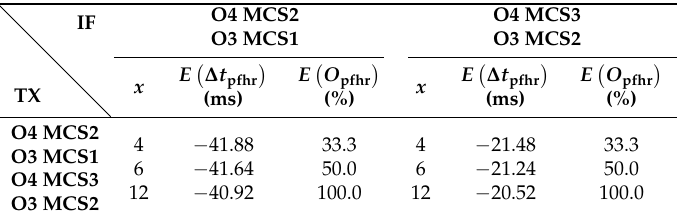
Table 5. Timing offsets and PHY frame header (PFHR) overlaps for given number of overlapping